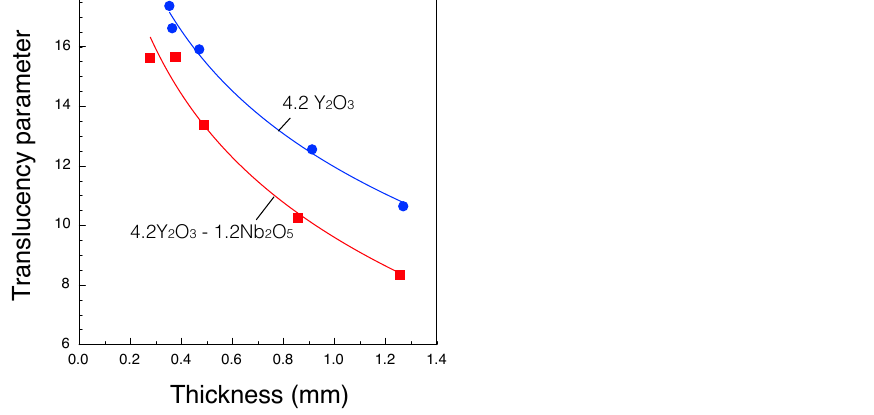
Figure 10. Thickness effect on translucency parameter of ZrO 2— 4.2 mol% Y 2 O 3 with and without 1.2 mol% Nb 2 O 5 (No. 16 and 3).